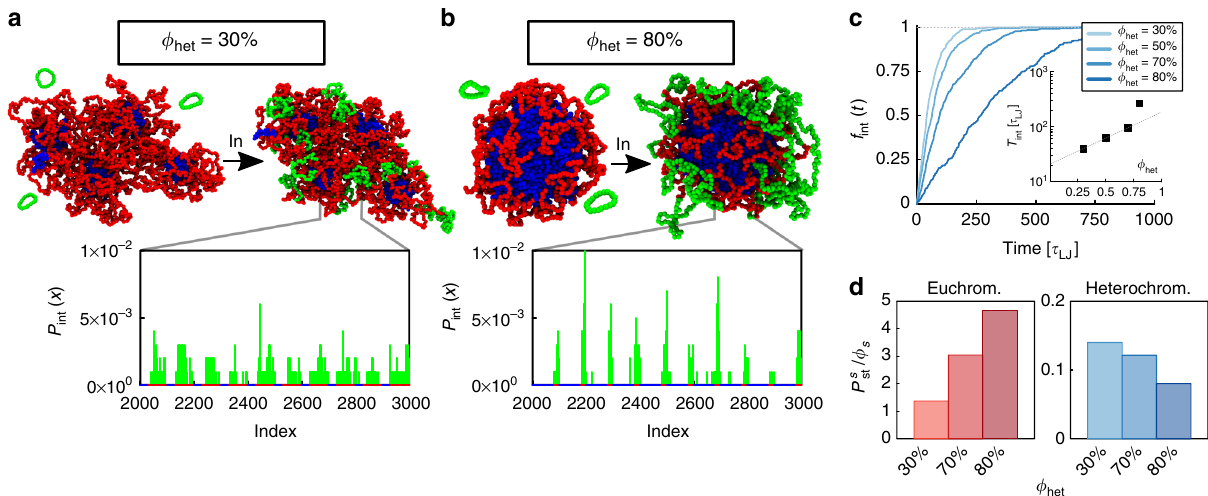
Fig. 4 Integration is slowed down in cells with large heterochromatin content. a , b Snapshots and probability distribution for a system with ϕ het = 30 and 80%, respectively. c Fraction of integrated loops f int as a function of time, for different levels of heterochromatin. In the inset, the integration time T int de fi ned as f int ( T int ) = 0.5 is shown to (super-)exponentially increase as a function of ϕ het . d Integration probability in state s , with s being either euchromatin (red) or heterochromatin (blue), normalised by the fraction of the host polymer in s , ϕ s . These show that the larger the fraction of heterochromatin, the more likely it is for a virus to be integrated in euchromatin. Source data are provided as a Source Data fi